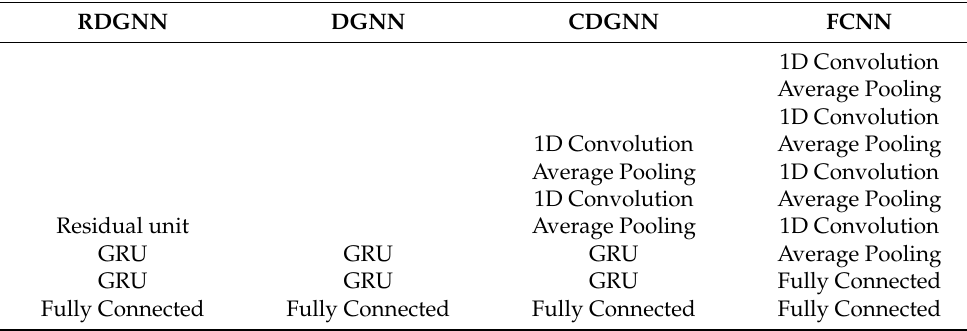
Table 3. Parameters of the